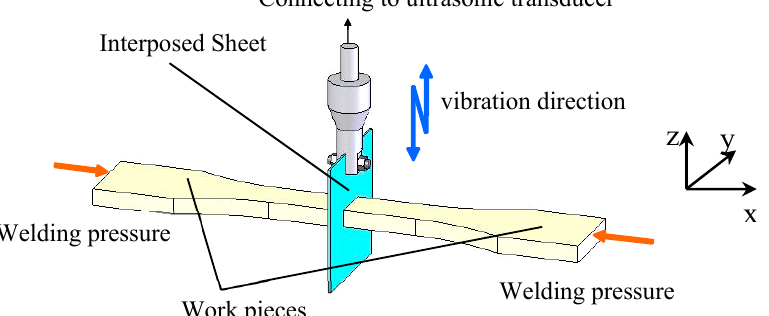
Figure 7. Welding principle schematic drawing followed by ultrasonic TWTP technology. Adapted from Reference [146,147].